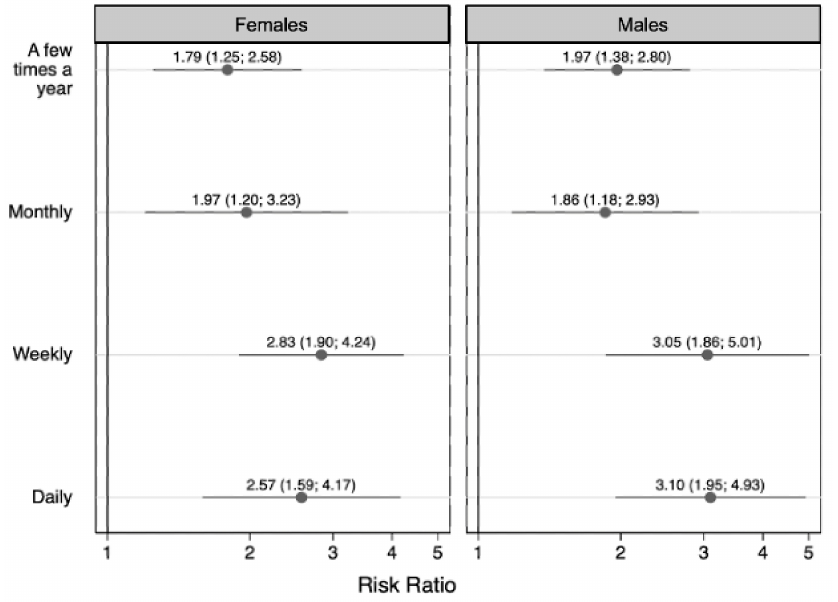
Figure 4. The sex-stratified association between having ever resided with someone with a substance use disorder and frequency of children’s anxiety (females n = 3201; males n = 3441). Symbols indicate relative risk ratios and lines indicate 95% confidence intervals. The referent group is children who never experienced anxiety.